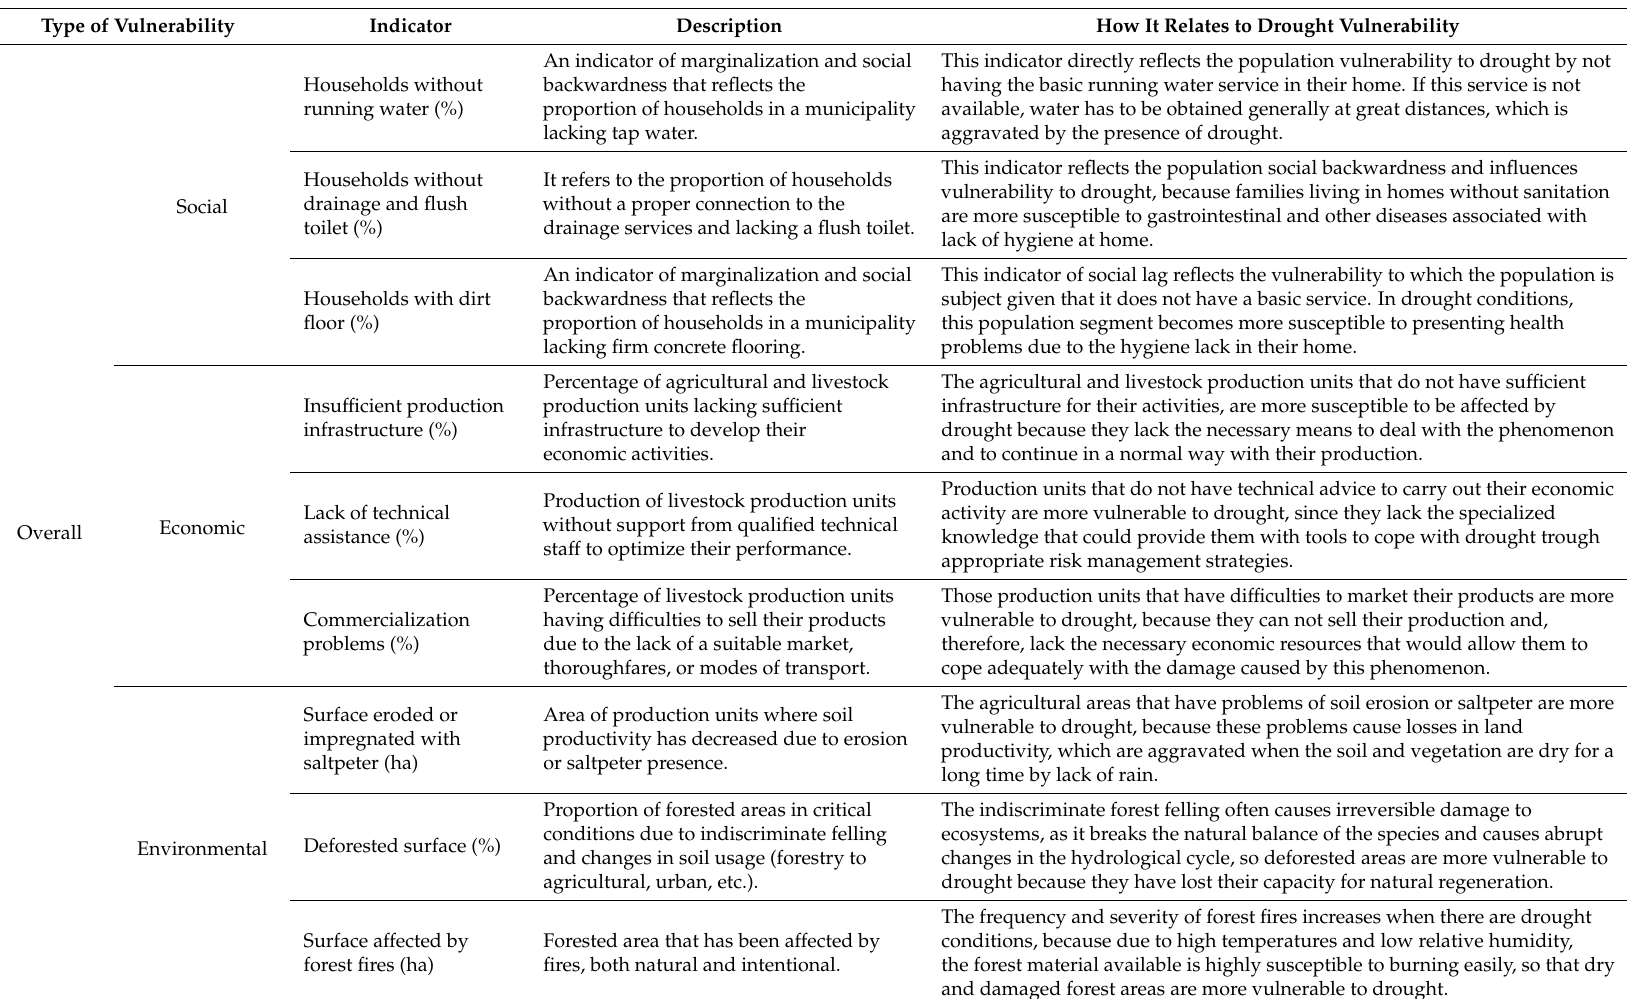
Table 3. Indicators of sensitivity to